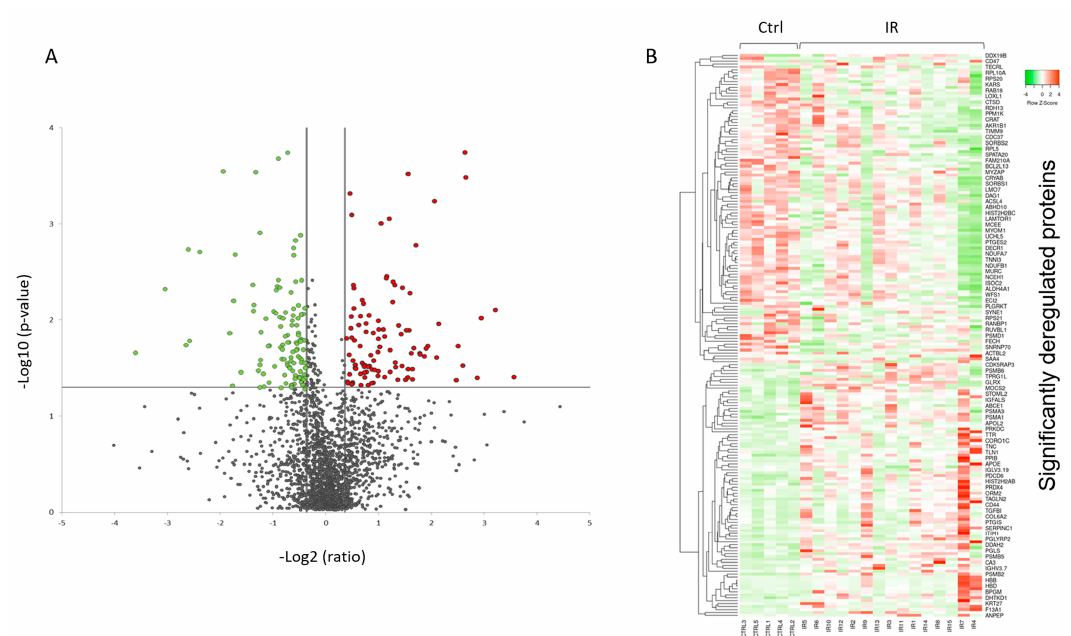
Figure 4. Graphical representation of quantitative proteomics data of human FFPE cardiac tissue after chronic irradiation. Proteins are ranked in a volcano plot according to the − log10 of their statistical p -value (y-axis) and log2 fold change (x-axis). The green and red points represent the significantly downregulated and upregulated proteins, respectively ( A ). The heat map shows hierarchical clustering (average linkage, Spearman ranked correlation) of significantly deregulated proteins in 5 controls (Ctrl) and 15 irradiated (IR) samples ( B ). The green bars indicate downregulation and the red bars upregulation. The analysis was performed using Heatmapper web server [34]. Detailed information of the proteomics features and individuals is given in Tables S1 and S2.